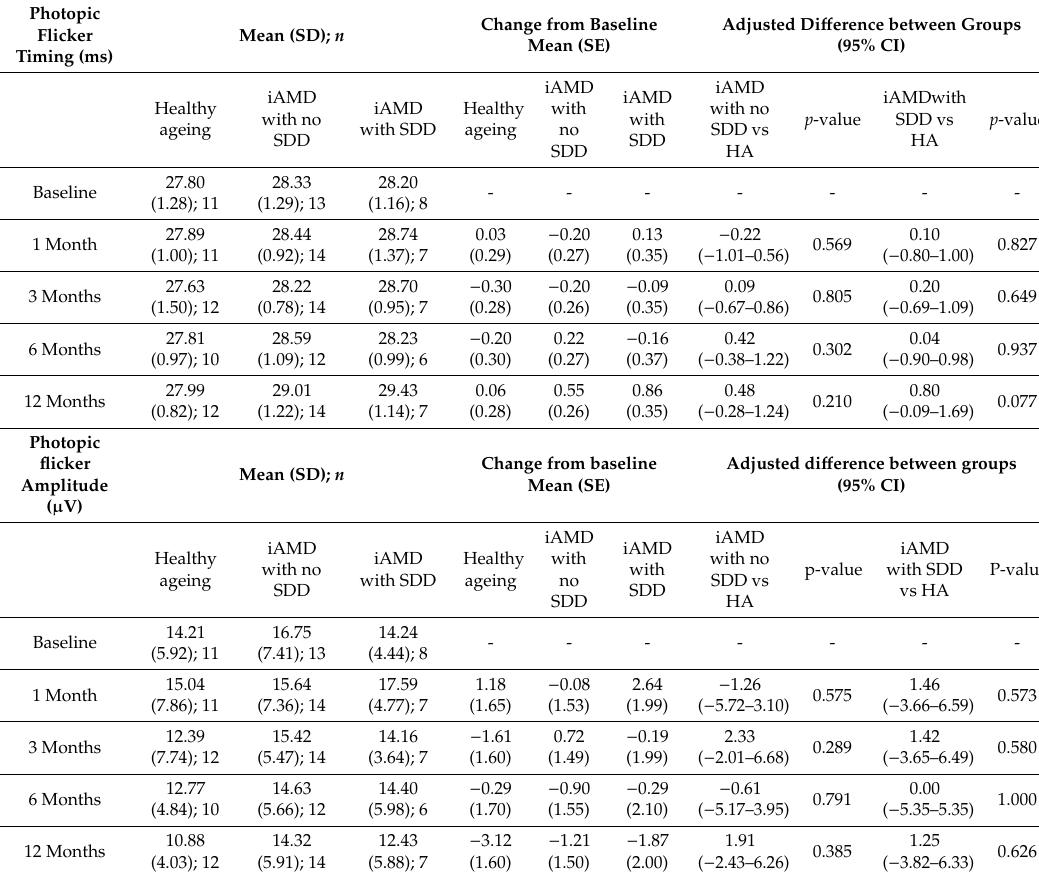
Table 5. Change in cone function outcome measures; photopic 28.3Hz flicker ERGs amplitude and